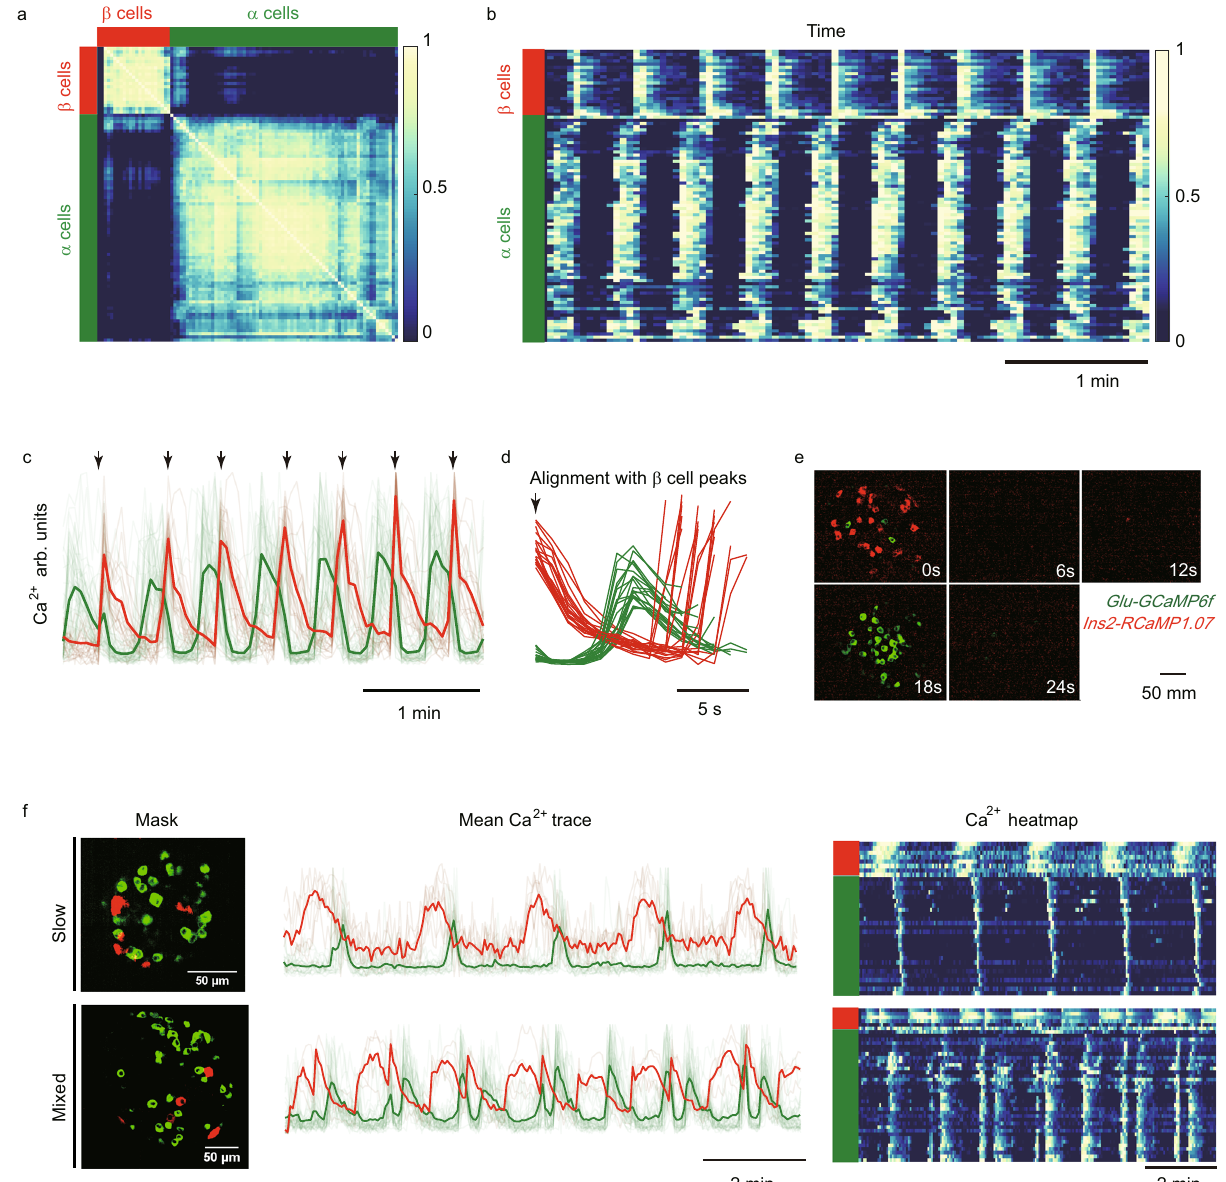
Fig. 3 α and β Cells are globally phase-locked during oscillation. a Correlation matrix (Pearson correlation coef fi cients) for Ca 2 + activity of Glu-Cre + ; GCaMP6f f/ + ; Ins2 - RCaMP1.07 islet cells under 10G stimulation. Cells are sorted according to cell types. β cells are indicated by the red bar, and α cells by the green bar. b The heat-map of time-dependent Ca 2 + activity for α and β cells under 10G stimulation. The color bar codes the normalized Ca 2 + intensity. Each row represents the same cell in a . c Mean Ca 2 + activity of α and β cells under 10G stimulation for the same islet as a . Single-cell traces are shown with light lines. The red trace represents β cells and green trace α cells ( n = 22 for β cells and n = 71 for α cells). d Mean Ca 2 + activity of α and β cells in c , aligned at each β cell peak. Each trace starts from a peak of β cell oscillation and stops in the next peak. e Sequential activation of α and β cells under 10G stimulation. We subtract the previous frame from the next frame of the original Ca 2 + images and average across oscillations (each oscillation is aligned with the maximum activation frame). The mean activation sequence uses 5 min Ca 2 + images (frame interval is 3 s). The β cells are colored red and α cells green. f Representative recordings of slow and mixed oscillations of Ca 2 + activity of α and β cells under 10G stimulation. Top: Slow oscillation; bottom: Mixed oscillation. The fi rst column, maximal projection of Ca 2 + masks ( α cells green and β cells red); second column, mean Ca 2 + trace of α and β cells (single-cell traces are shown with light lines); third column, heat-map of α and β cells ’ Ca 2 + activity. The color bar codes the normalized Ca 2 + to achieve synchronization 43 – 47 , α cells do not express gap junc- with similar temporal characteristics was also present in slow and tion proteins and are thus not physically connected 48 . Because mixed oscillations (Fig. 3f, Movies 3 and 4), suggesting a common mean Ca 2 + peaks of α cells displayed a fi xed delay to those of β underlying mechanism. cells (~20 s), we hypothesized that the highly synchronous α cell activity might be due to stable phase-locking to the β cell activity (Fig. 3c and d). Consistently we observed global α cell activation Variable delay of β cell activation after α cell determines the after the turning-off of β cells (Fig. 3e). Intriguingly, phase-locking oscillation mode . To non-biasedly sort out critical parameters